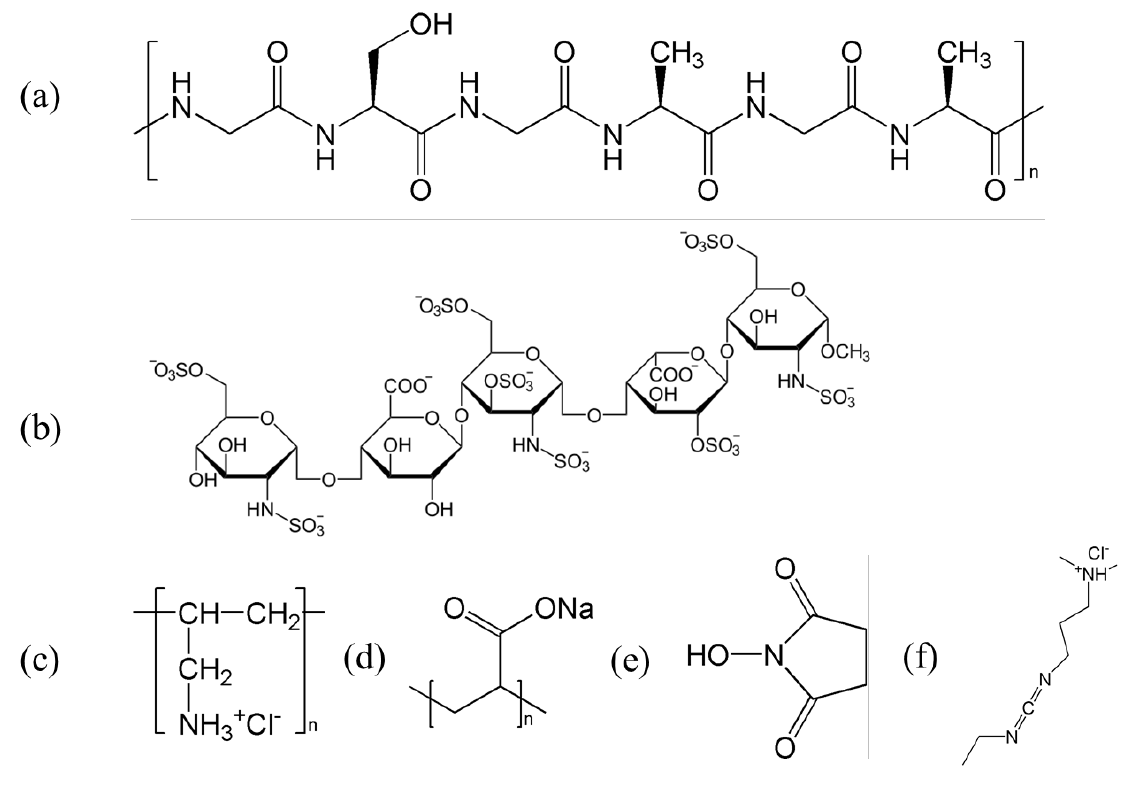
Figure 13. Chemical structures of the materials used: ( a ) silk fibroin; ( b ) LMWH with two typical GAG repeats with multiple sulfate groups; ( c ) PAH; ( d ) PAA; ( e ) EDC and ( f )